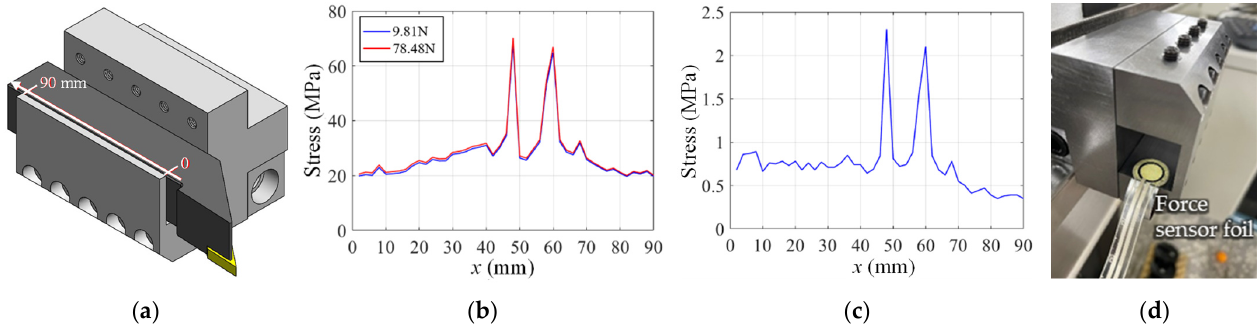
Figure 7. The determination process of the position of the film force sensor: ( a ) the schematic diagram of the longitudinal coordinate of the turning tool; ( b ) the stress distribution at the bottom surface of the turning tool along its longitudinal axis when subject to cutting force; ( c ) the stress difference of ( b ); ( d ) the bonding position of the film force sensor.